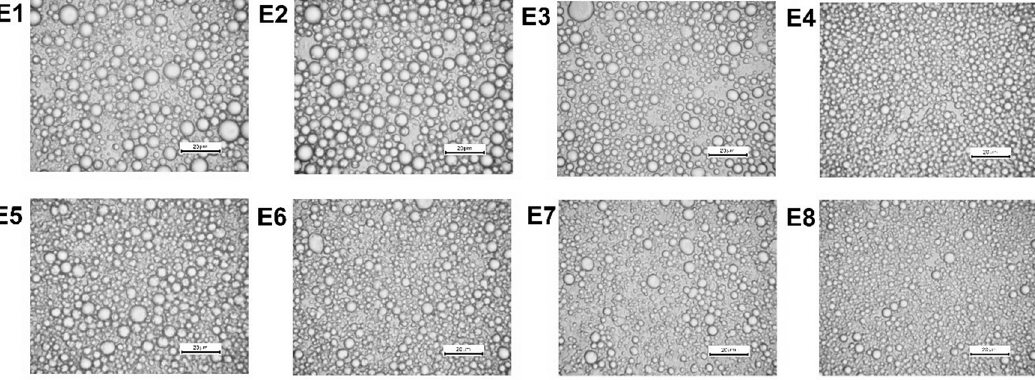
Figure 7. Viscosity of the emulsions after 24 h from their manufacturing and 30 days of storage (as a mean value of 3 determinations ± SD) Different letters indicate statistically significant difference ( p < 0.05).